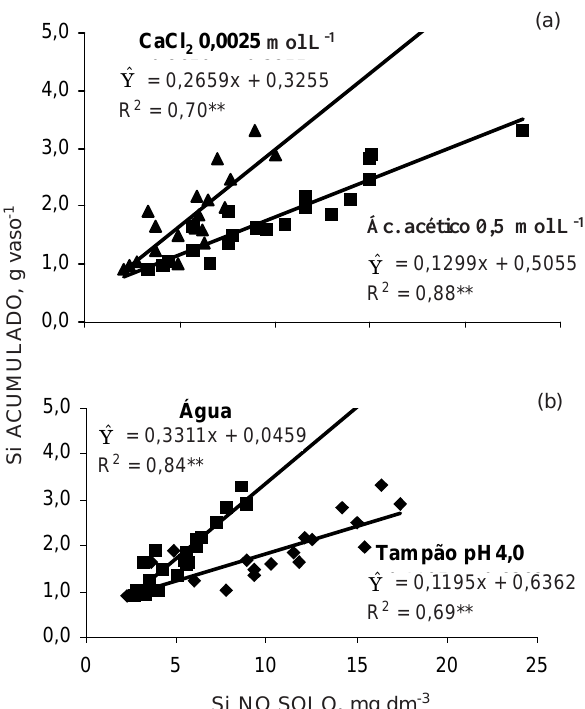
Figura 1. Relação entre o Si extraído pelos extratores ácido acético 0,5 mol L -1 e cloreto de cálcio (a) tampão pH 4,0 e água (b) e o Si acumulado na parte aérea de plantas de arroz de sequeiro. (** significativo a